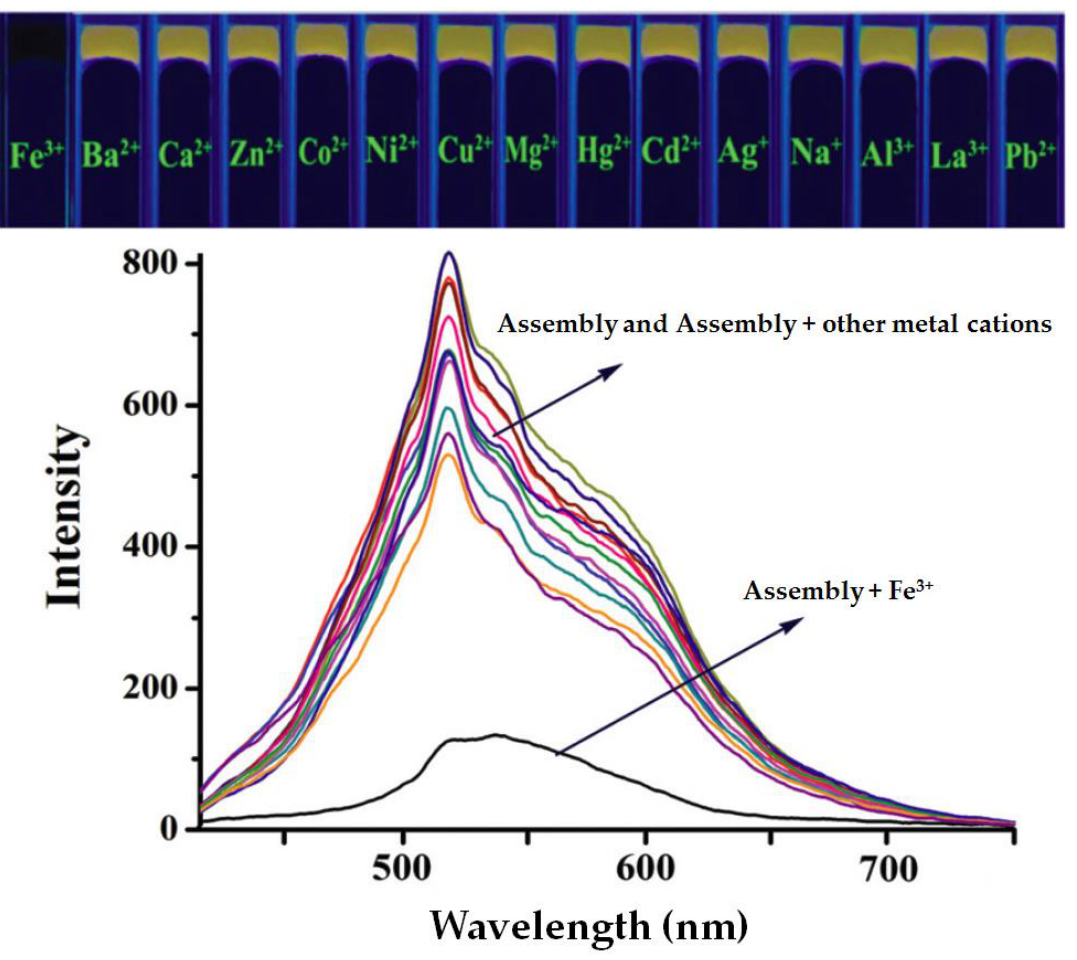
Figure 7. Fluorescence spectra of X13 ⊃ G6 with the addition of various metal cations in aqueous solutions. Reproduced with permission from [28]. Copyright Royal Society of Chemistry, 2019.